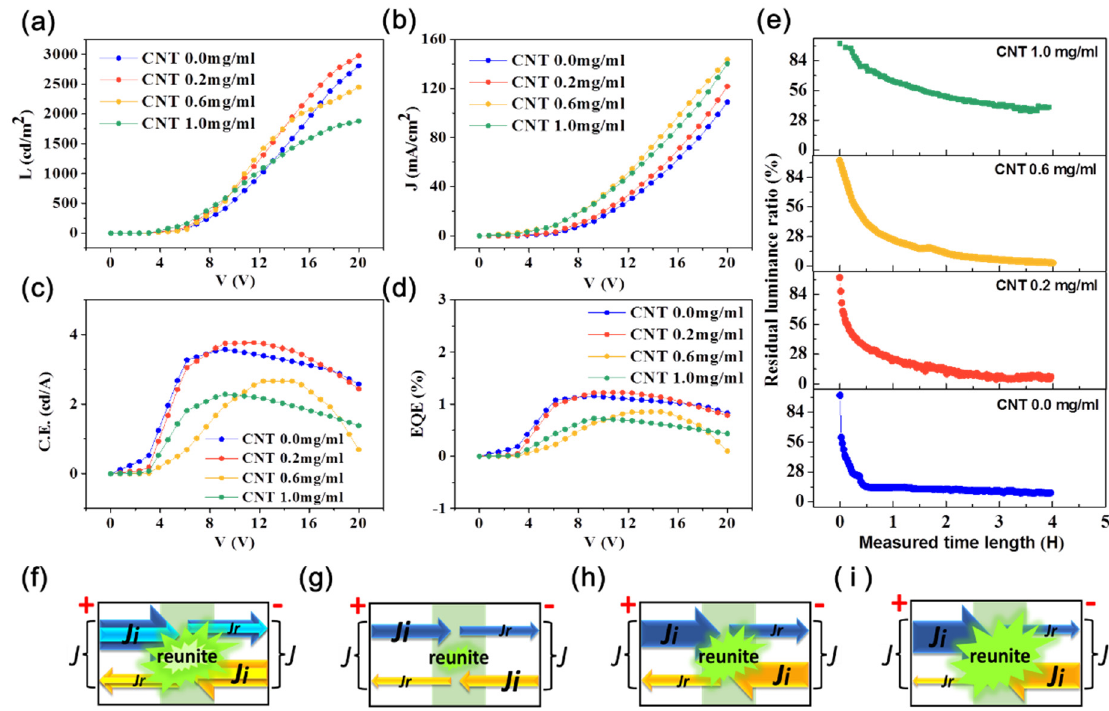
Figure 7. The performances of OLEDs using CNT/P-NTCFs as anodes using CNT solutions with different concentrations (0.0–1.0 mg/mL) and applied with different voltages: ( a ) current density, ( b ) luminance, ( c ) current efficiency, ( d ) external quantum efficiency, and ( e ) lifetime. Schematics of current flow in OLEDs in different states: ( f ) voltage changing from low to high with a certain CNT content, ( g ) low voltage (more CNTs and less CNTs), ( h ) high voltage and more CNTs, ( i ) high voltage and fewer CNTs. ( J is the total current of the anode or cathode. The cathode and anode of the same device have the same total current. Marked with J i is the injection limiting current. Marked with J r is the current injected by anode (cathode) but not compounded in the luminescent region and flowing to cathode (anode). The green region represents the light produced by the recombination of electrons and holes.)